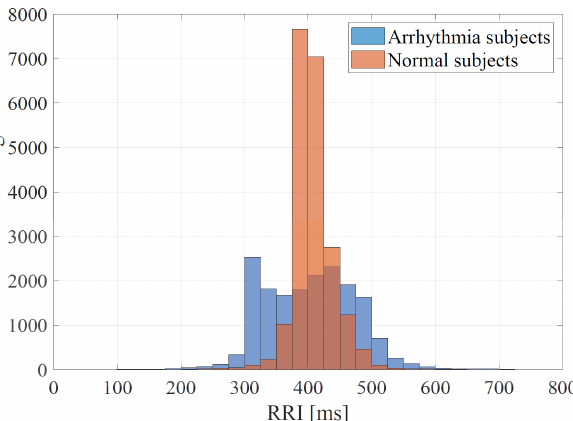
Figure 4. The distributions of the estimated RRIs for all the arrhythmia and normal subjects in the database used in this paper.